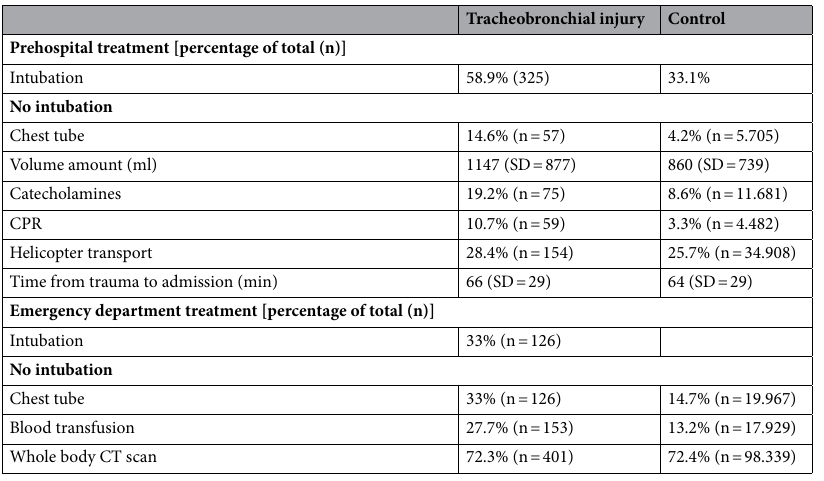
Table 3. Non-surgical treatment of patients with tracheobronchial injuries and among the control group (CPR: cardiopulmonary